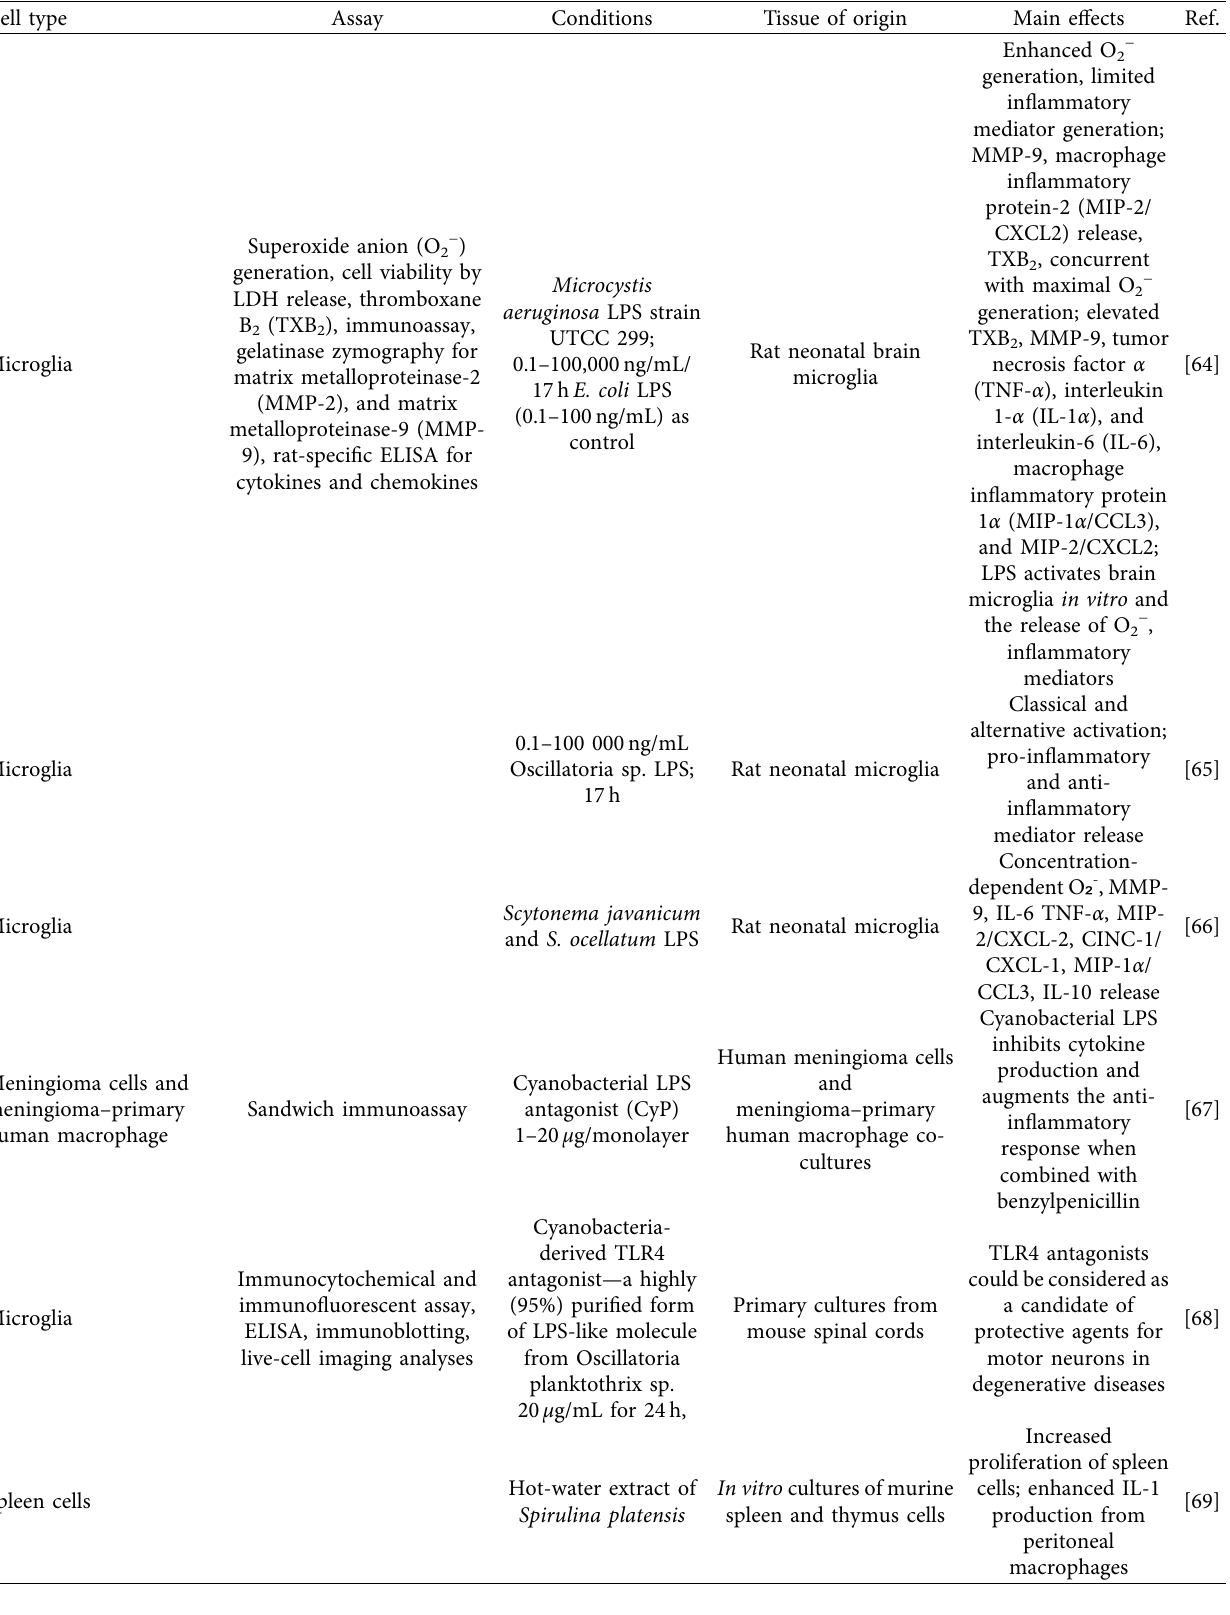
Table 6: Cytotoxicity of